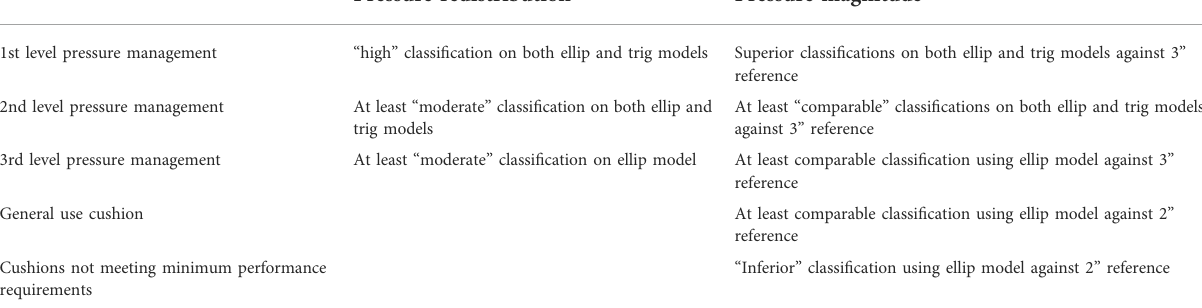
TABLE 8 Proposed wheelchair cushion classi fi cation